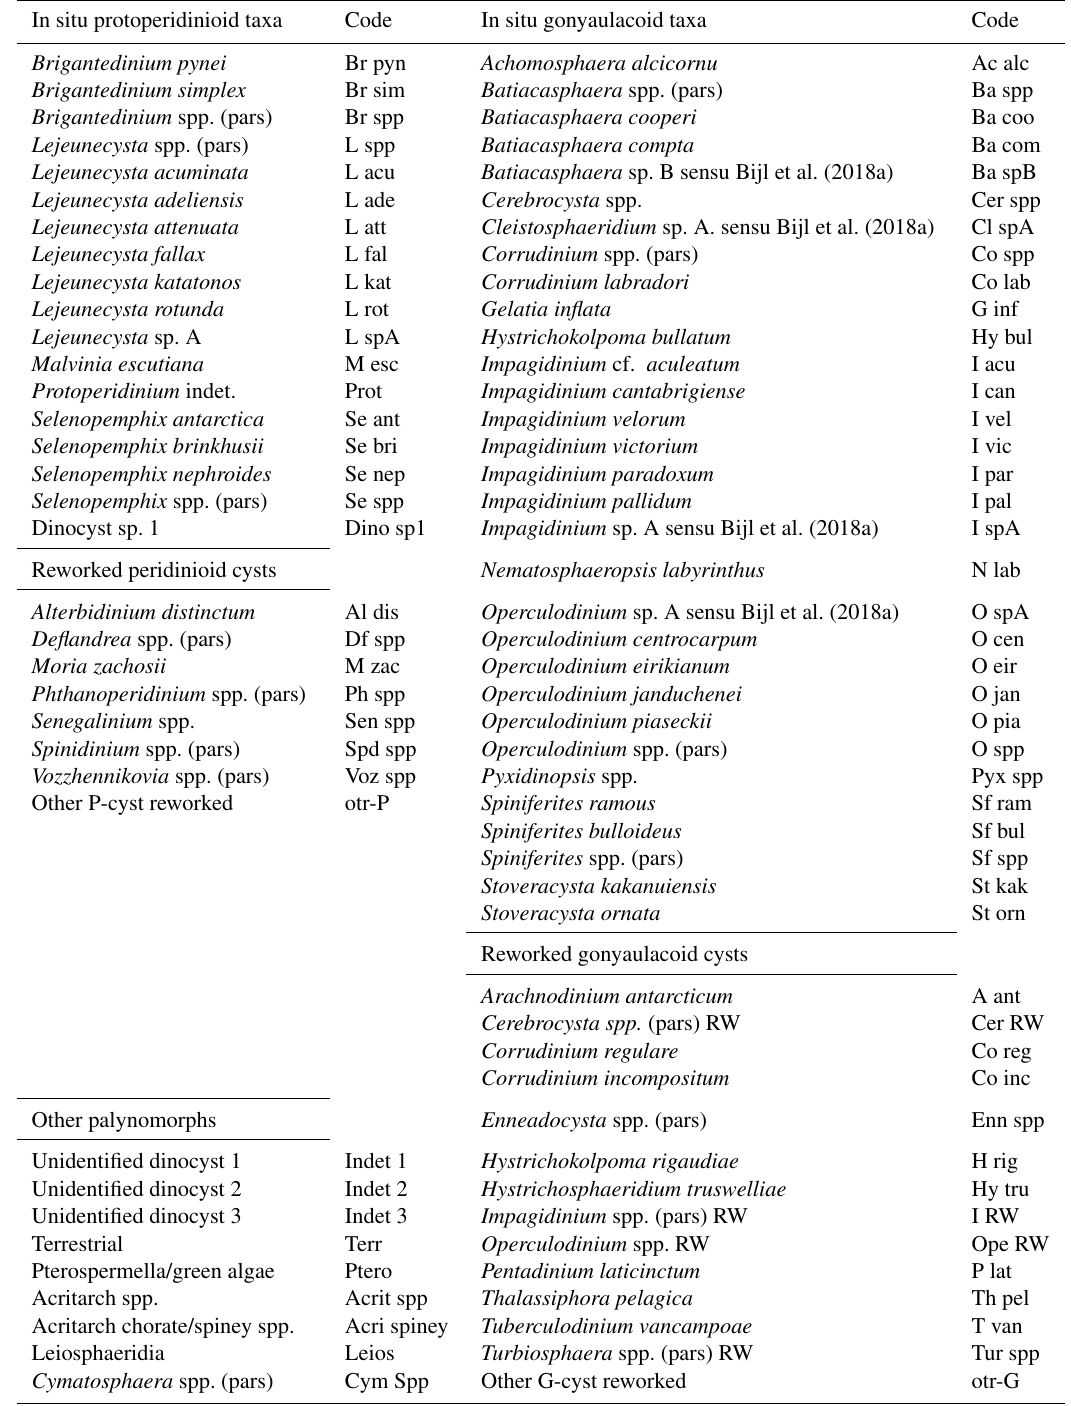
Table 1. List of palynomorphs and their abbreviated codes found in the CA plot (Fig. 5). Assumed in situ and reworked dinoflagellate cyst taxa are assigned to protoperidinioid (P-cyst) taxa and gonyaulacoid (G-cyst) taxa. “indet.” denotes